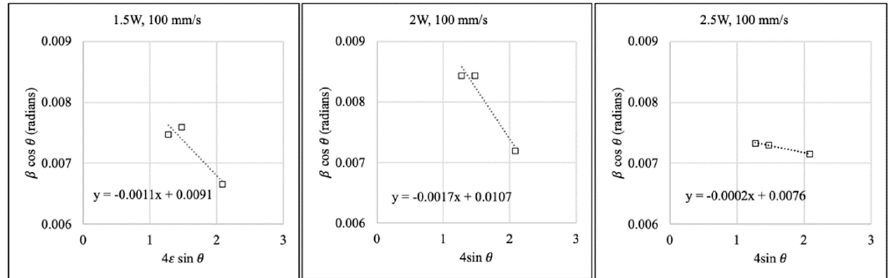
Figure 18. Williamson − Hall plots of NiO thin films, which were sintered by 1.5 W, 2 W, and 2.5 W, with 100 mm/s laser scanning speed (the squares were from XRD peaks 111, 200 and 220).